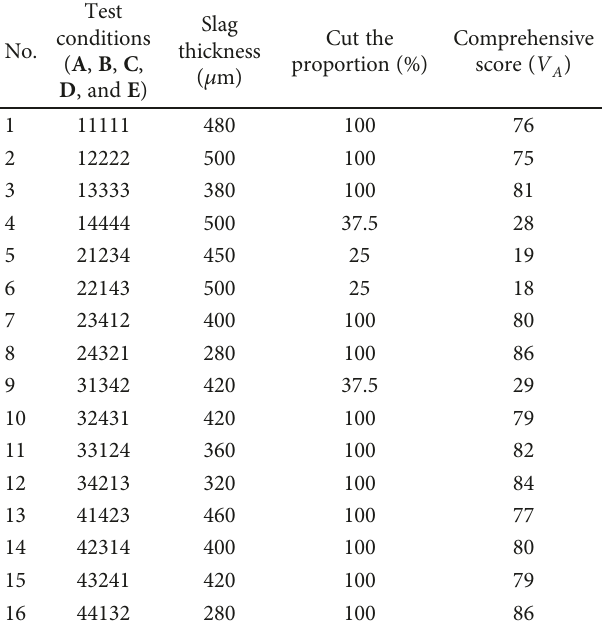
Table 3: Comprehensive evaluation table of orthogonal